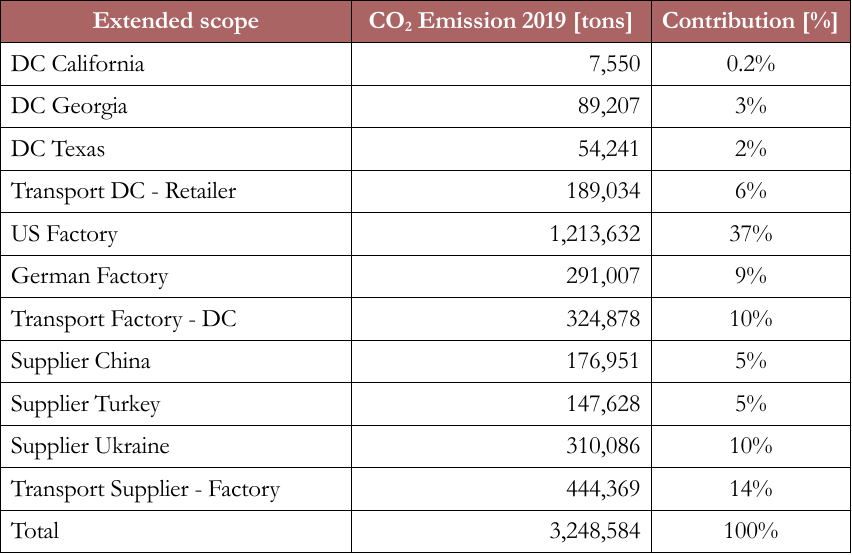
Table 2. Carbon emission split under the extended scope